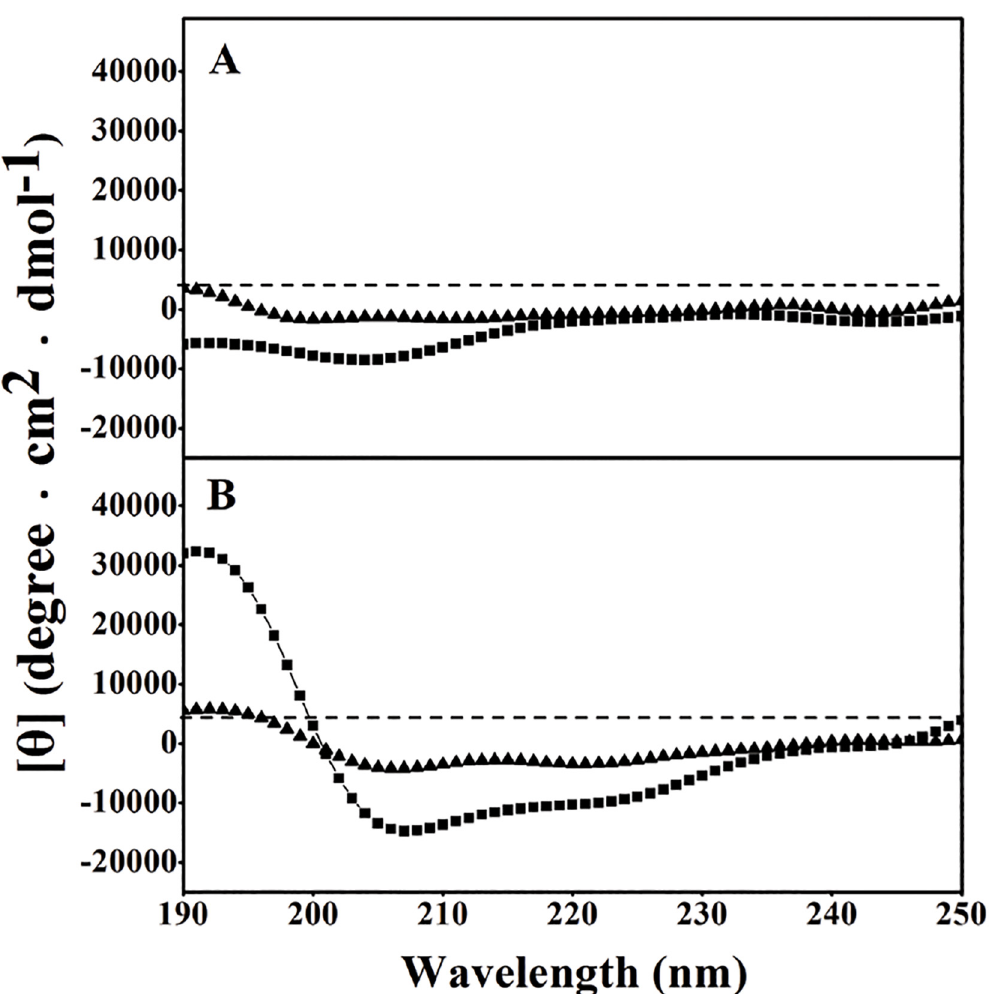
Fig 1. Circular dichroism spectra of peptides. ( A ) In benign medium (50 mM KH 2 PO 4 /K 2 HPO 4 containing 100 mM KCl, pH 7.4) at 25°C and ( B ) in the presence of 50% TFE at 25°C. The symbols used are as follows: & , HPRP-A1 peptide; ▲ , HPRP-A1-TAT